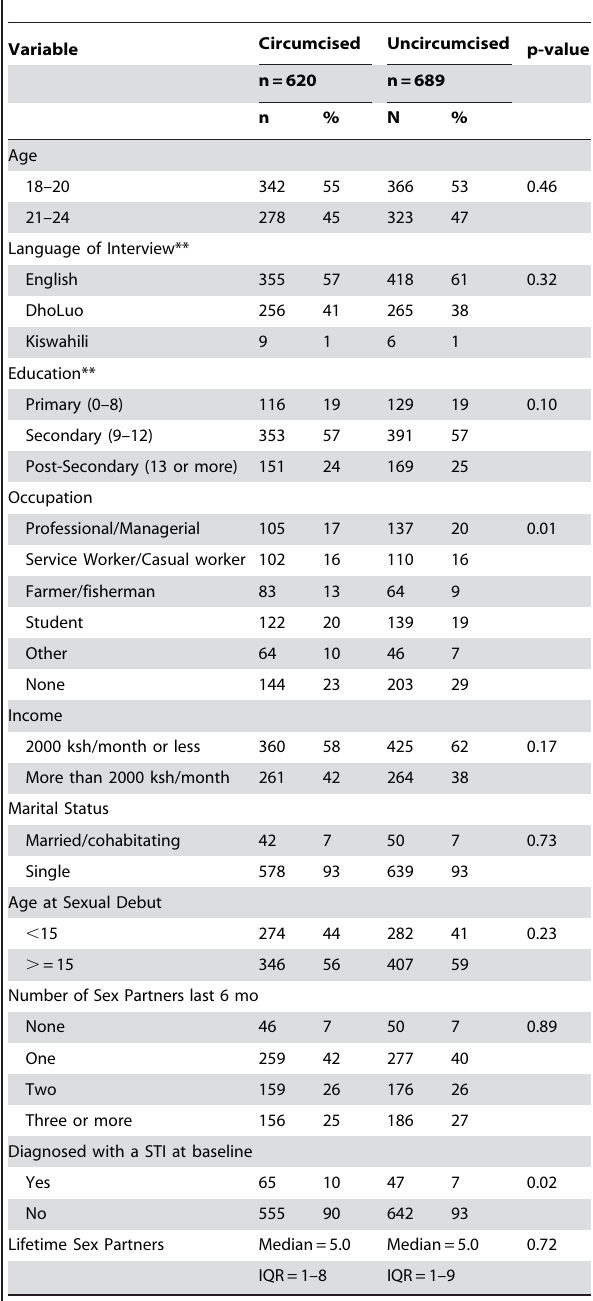
Table 1. Baseline Comparability of Men in Circumcised and Uncircumcised Group